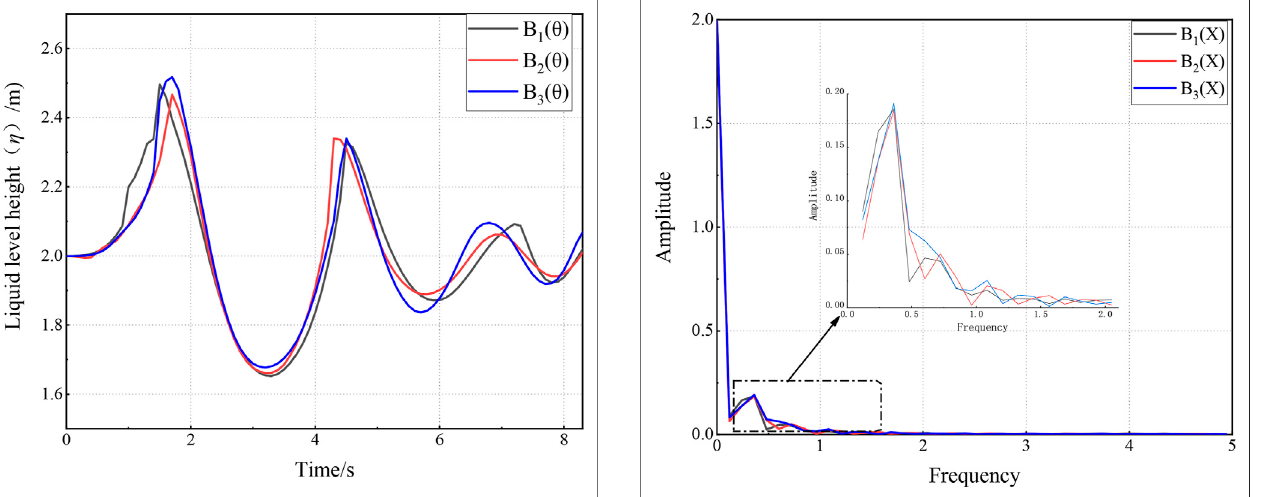
FIGURE 15 | Fourier transform plot of far- fi eld ( x /h (cid:1) 2) surge.